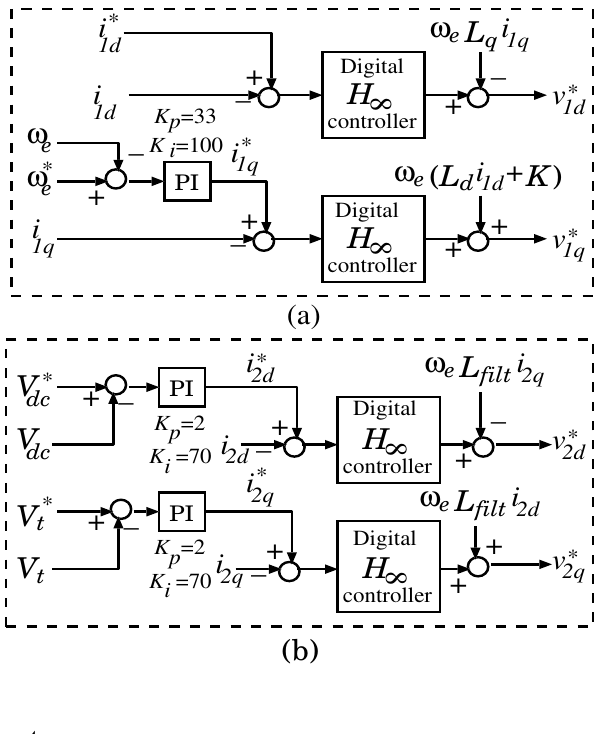
( a ) Generator-side converter control method; ( b ) Grid-side